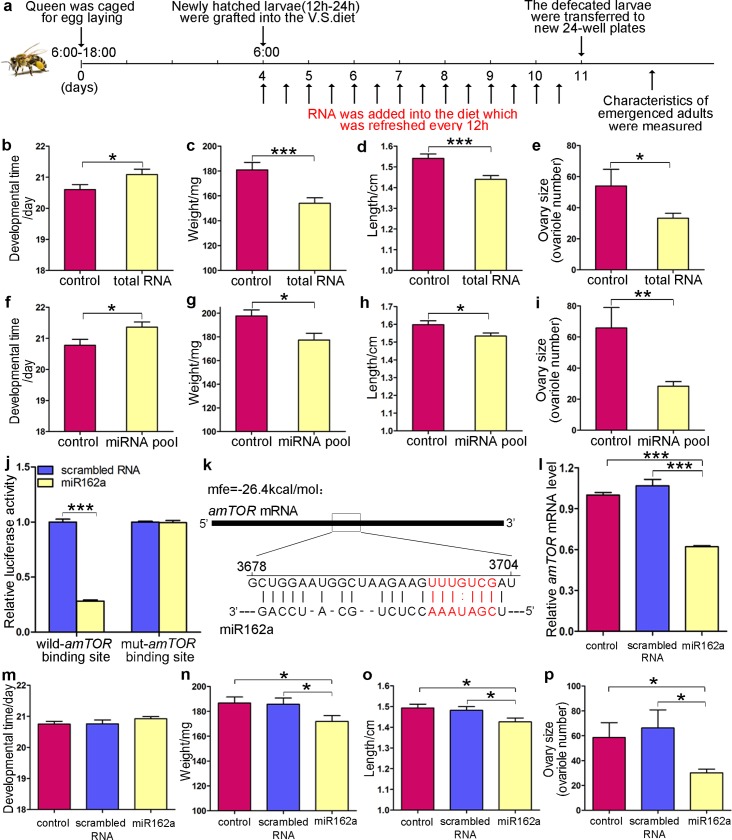
Effects of plant RNAs, plant miRNA pool and miR162a on honeybee phenotypes.(a) Flow chart of the experimental design. (b-e) Developmental time (b), body weight (c), length (d) and ovary size (e) of honeybees that were reared with the control diet (equal volume of DEPC water added) or a diet containing total pollen RNA (n = 25–30). Data are represented as the mean ± SEM. *p < 0.05; ***p < 0.001, Student’s t-test. (f-i) Developmental time (f), body weight (g), length (h) and ovary size (i) of honeybees that were reared with the control diet or a diet supplemented with the synthetic miRNA pool (n = 25–30). Data are represented as the mean ± SEM. *p < 0.05; **p < 0.01, Student’s t-test. (j) Firefly luciferase reporters containing the potential binding site or mutant binding site for miR162a in the amTOR gene were co-transfected with scrambled RNAs or miR162a into 293T cells. At 24 h post-transfection, cells were assayed using luciferase assay kits. Data are represented as the mean ± SEM. ***p < 0.001, Student’s t-test. (k) Schematic illustration of the hypothetical duplex formed by the interaction between amTOR (top) and miR162a (bottom) in honeybees. The predicted free energy of the hybrid is indicated. (l) qRT-PCR analysis of the levels of amTOR mRNA in 4th instar honeybee larvae reared with control diets or diets supplemented with synthetic miR162a. Error bars represent SEM. ***p < 0.001, one-way ANOVA. (m-p) Developmental time (m), body weight (n), length (o) and ovary size (p) of honeybees reared with the control diet or a diet supplemented with synthetic scrambled RNA or miR162a (n = 25–30). Data are represented as the mean ± SEM. *p < 0.05, one-way ANOVA.